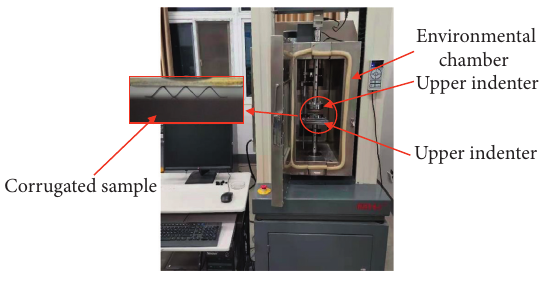
Figure 7: Experimental